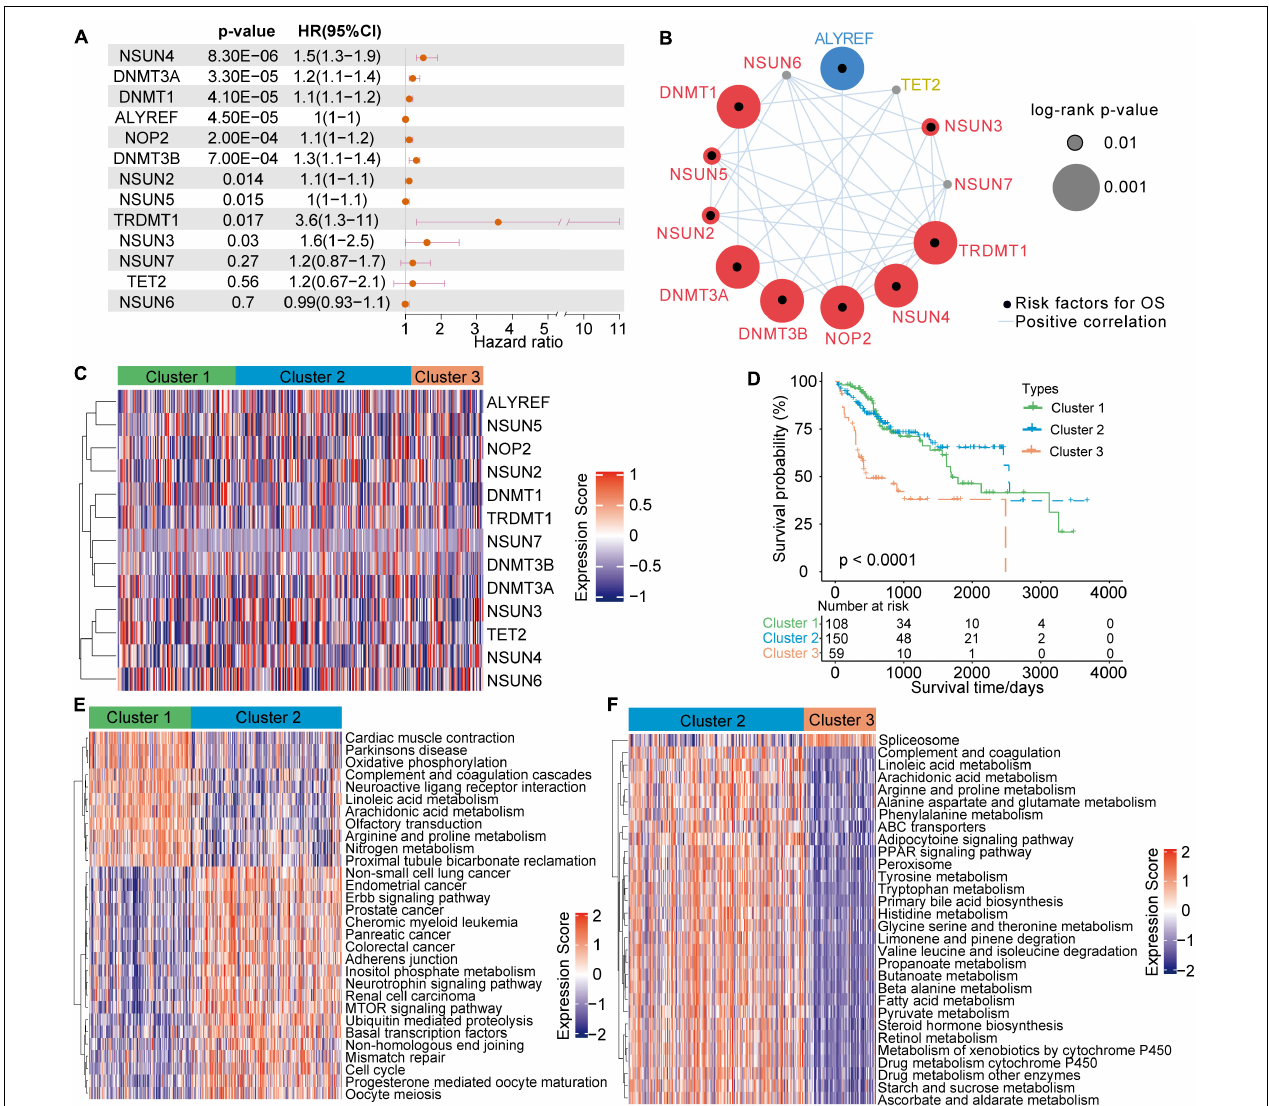
FIGURE 2 | 5-Methylcytosine methylation alteration patterns and related biological characteristics. (A) Univariate Cox regression analysis of the 13 m 5 C regulators in patients with HCC. (B) The network of m 5 C regulators and their prognostic significance for HCC patients. (C) Unsupervised clustering analysis of 13 m 5 C regulators in HCC. (D) Survival analysis of HCC patients in the TCGA-LIHC cohort according to the three m 5 C clusters. (E,F) A heatmap of GSVA results shows the representative hallmark pathways associated with distinct m 5 C modification patterns.